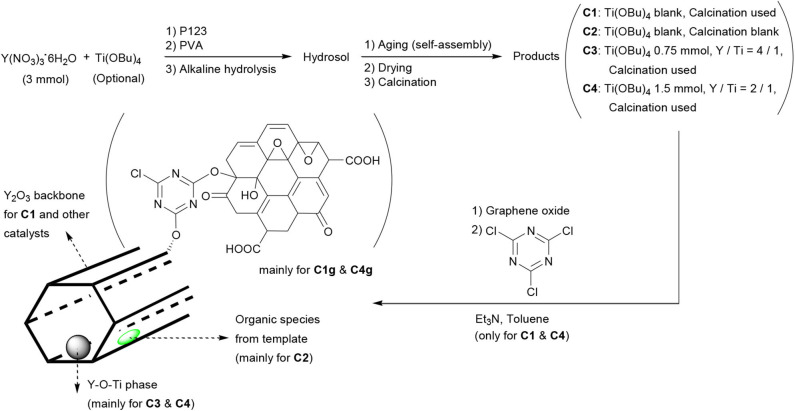
Formation and structural models of synthesized catalysts.